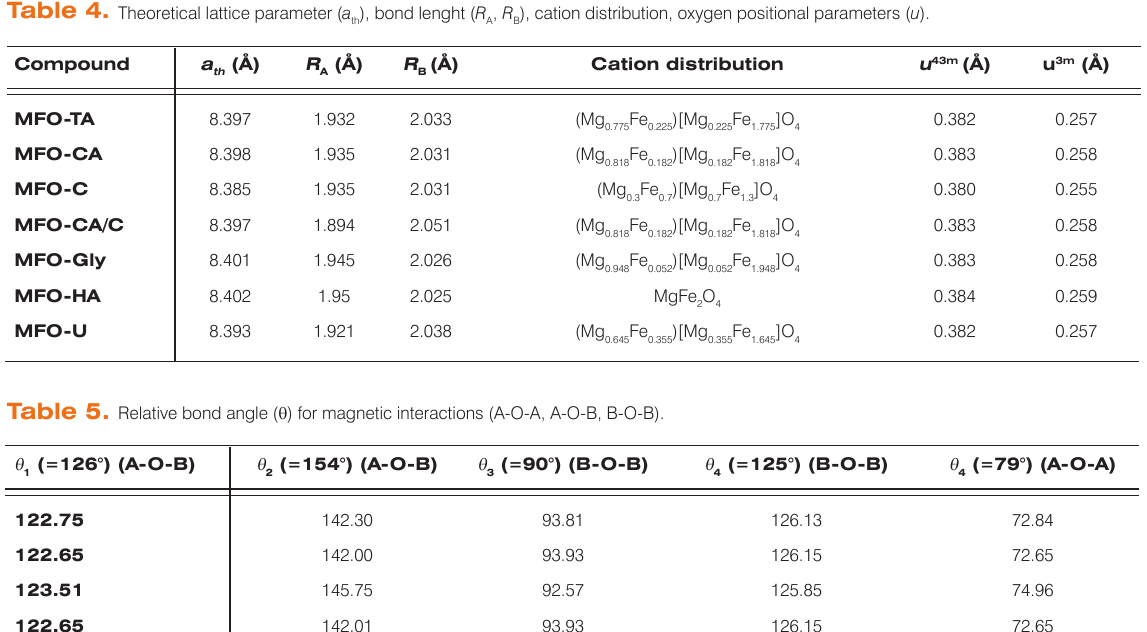
), bond lenght ( R , R ), cation distribution, oxygen positional parameters ( u ). th A B